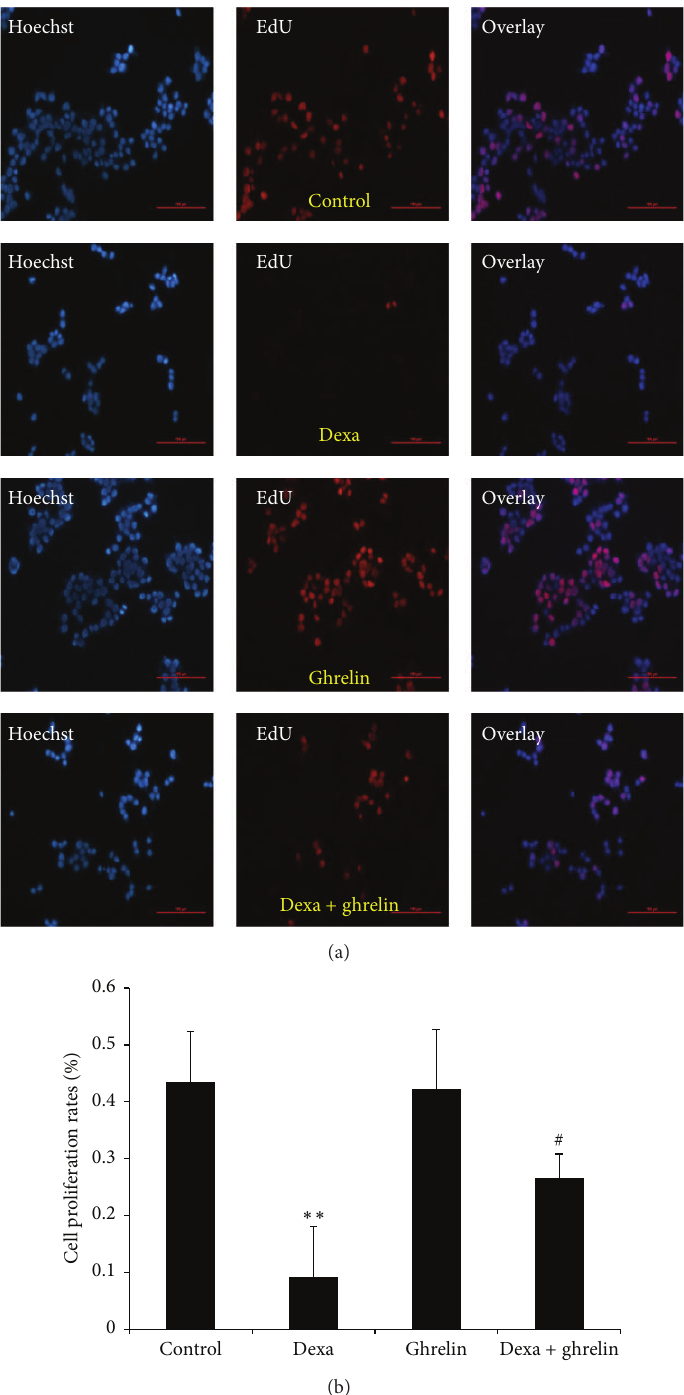
Figure 2: Effects of ghrelin and dexamethasone on DNA synthesis in INS-1 cells. (a) INS-1 cells were cultured in complete medium (control), 0.1 𝜇 M dexamethasone, 0.1 𝜇 M ghrelin, and 0.1 𝜇 M dexamethasone + 0.1 𝜇 M ghrelin for 48 h. EdU-labeled INS-1 cells were assessed using fluorescent microscopy. All cell nuclei were Hoechst 33342-positive (blue) and all replicating cells were EdU-positive (red). (b) The graph represents the percentage of EdU-labeled proliferative INS-1 cells. Data are presented as the mean ± SD. ∗∗ 𝑝 < 0.01 versus control group; # 𝑝 < 0.05 versus dexamethasone